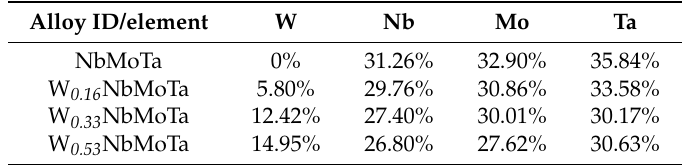
Table 2. Chemical composition (in at.%) of four refractory alloys produced by LCD.